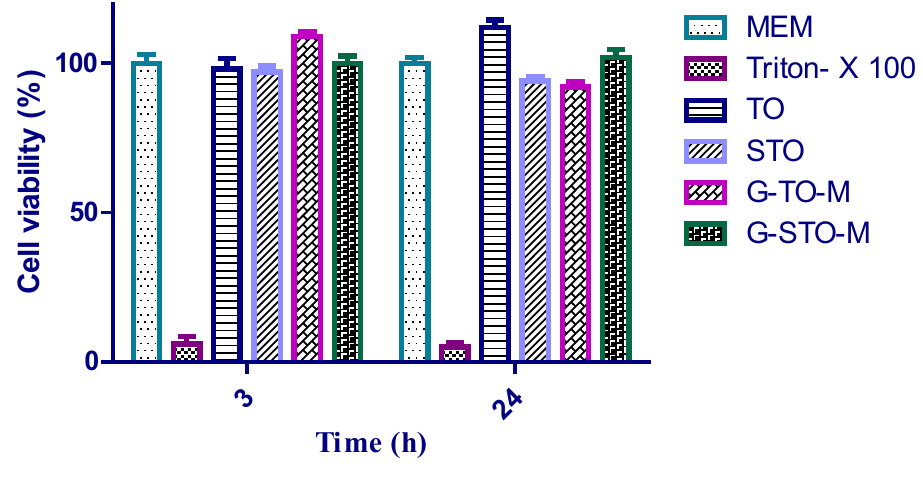
Figure 7. Cell viability studies.